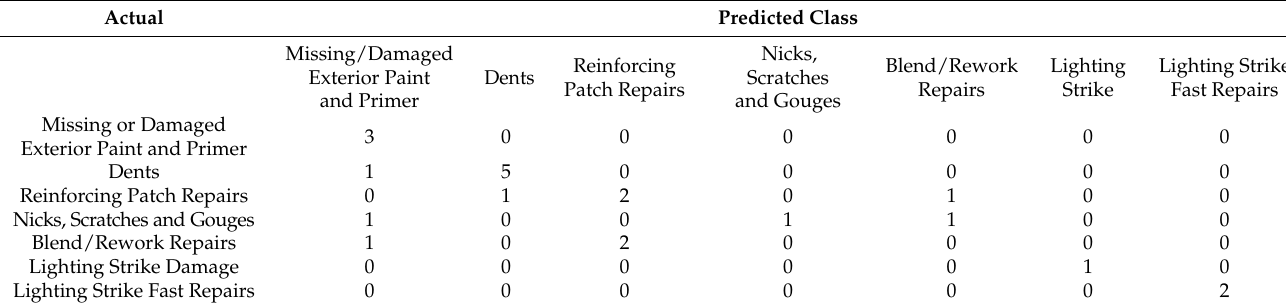
Table 14. Confusion matrix of EfficientNetB4.